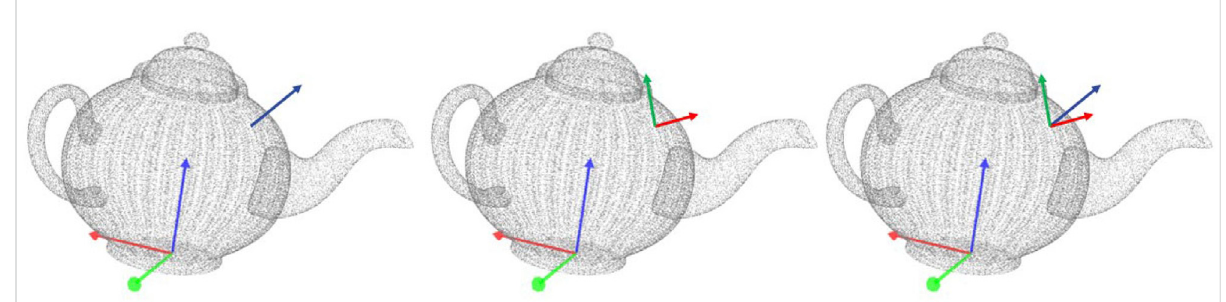
FIGURE 3 Computationofasurfacefeatureonateapot.(left)thefullpointcloudoftheteapotwithitsreferenceframe.Thenormalofthesampledpointis shown as a blue arrow (middle) the principal curvature directions are drawn for the same point as red and green arrows (right) the associated reference frame for the surface feature with respect to the object ’ s reference